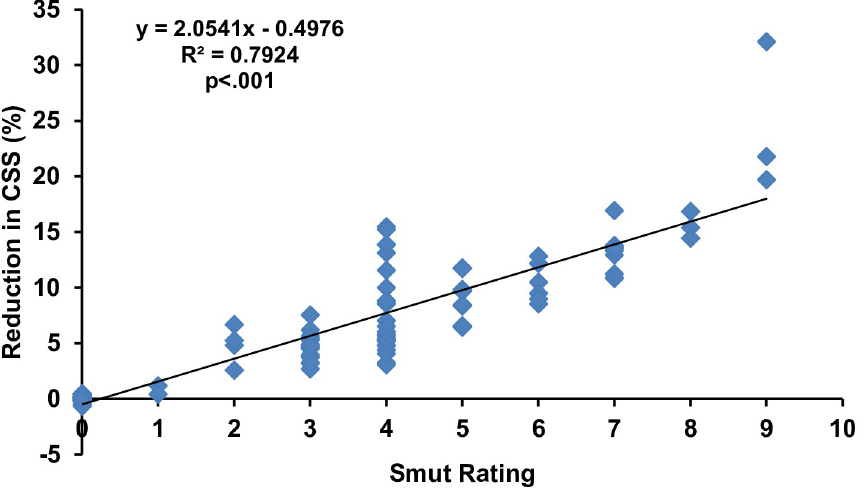
Fig 5. Regression analysis of brix percentage with whip smut disease rating. Note: The smut rating is not a linear scale. It’s based on the transformation explained in methods from linear incidence value to the rating. Accordingly, the resulting disease incidences were converted into 0–9 disease rating scale [41], where 0: no disease, 1: 0.1–2.5%, 2: 2.6– 5.5%, 3: 5.6–7.5%, 4: 7.6–12.5%, 5: 12.6–15.5%, 6: 15.6–18.0%, 7: 18.1–22.5%, 8: 22.6–25.5% and 9: 25.6–100%.